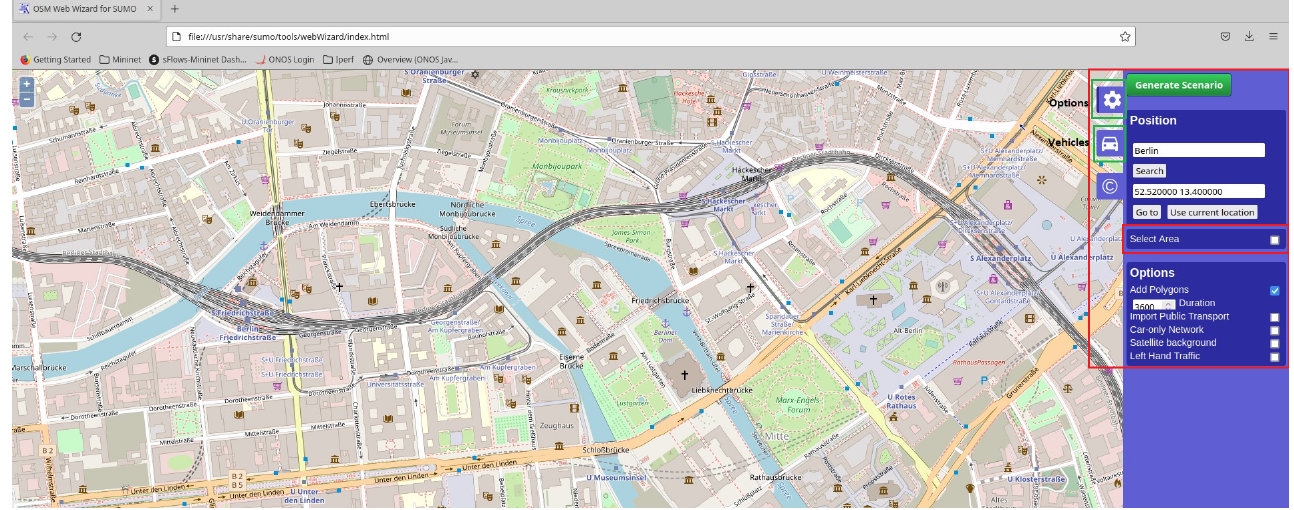
Figure 40. OSM Web Wizard home